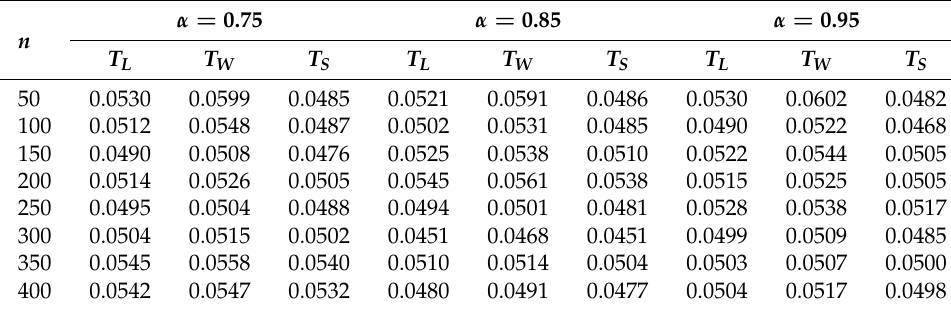
Table 3. The empirical levels of statistics ( T L , T W , T S ) for Case (A2).